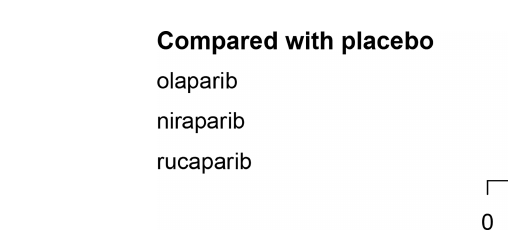
FIGURE 9 | The forest plot of grade 3-4 AEs in the maintenance phase.